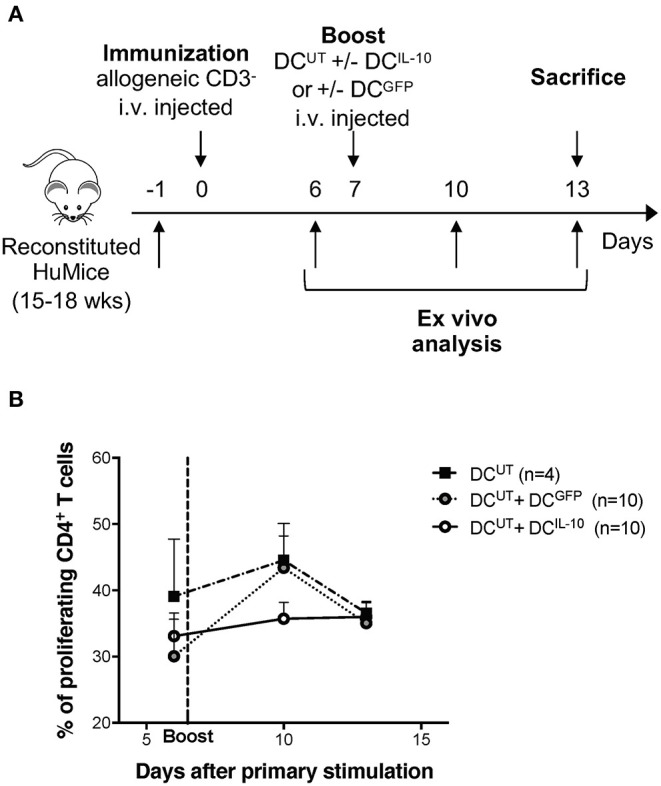
DCIL−10 prevent allo-specific T cell reactivation in huMice. NSG mice were transplanted with 105 CD34+ human cells. Reconstituted huMice were immunized with i.v. injected irradiated allogeneic CD3− cells (n = 24). On day 7, immunized huMice were boosted with autologous un-transduced DC (DCUT) alone (n = 4), or in combination with DCIL−10 (DCUT+DCIL10) (n = 10), or DCGFP (DCUT+DCGFP) (n = 10). (A) Experimental design is depicted. (B) Peripheral blood CD4+ T cell proliferation was assessed by Ki67 staining at day 6, 10, and 13 from immunization. Mean values and SEM are shown.